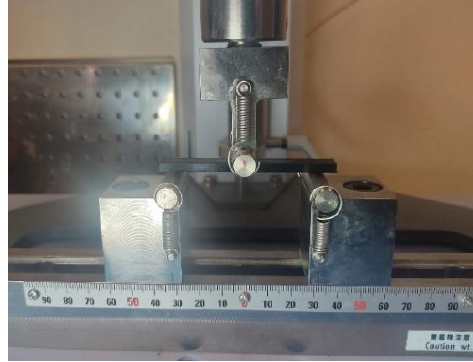
Figure 6. Bending